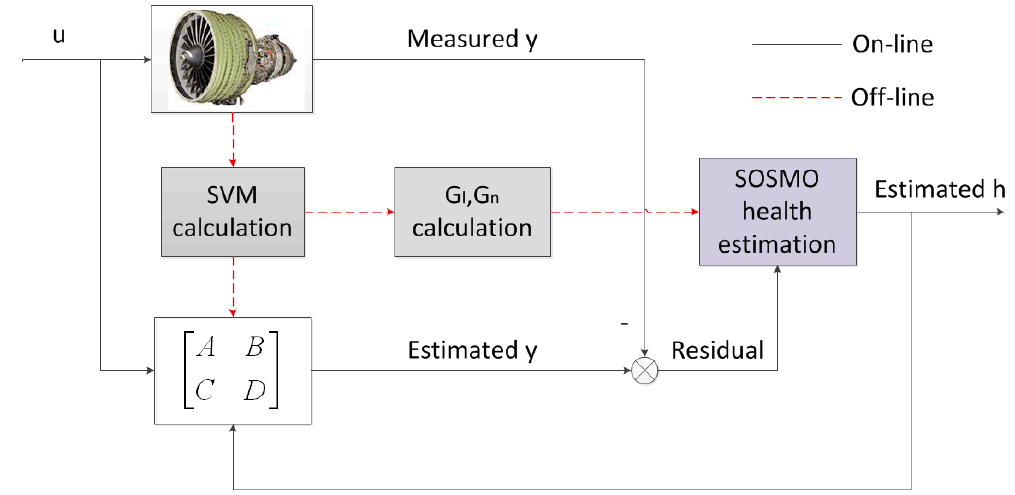
Figure 2. Schematic of relationships in the GPHM.